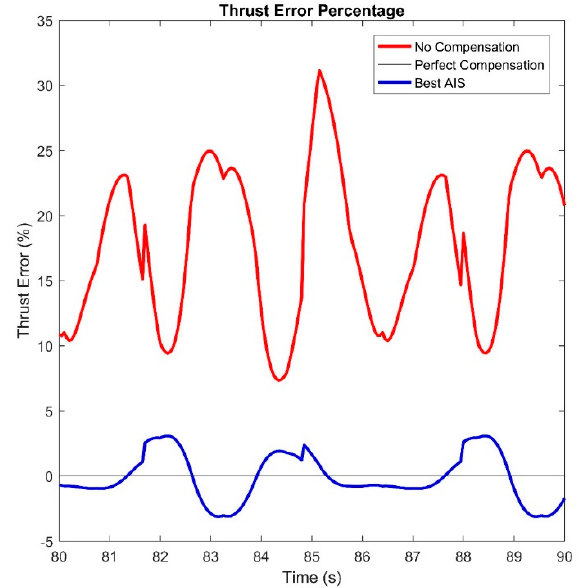
Figure 12. Error in thrust is shown for both the original and compensated vehicles compared to the unfaulted vehicle. Only the last 10 seconds of the vehicle’s simulation are shown.